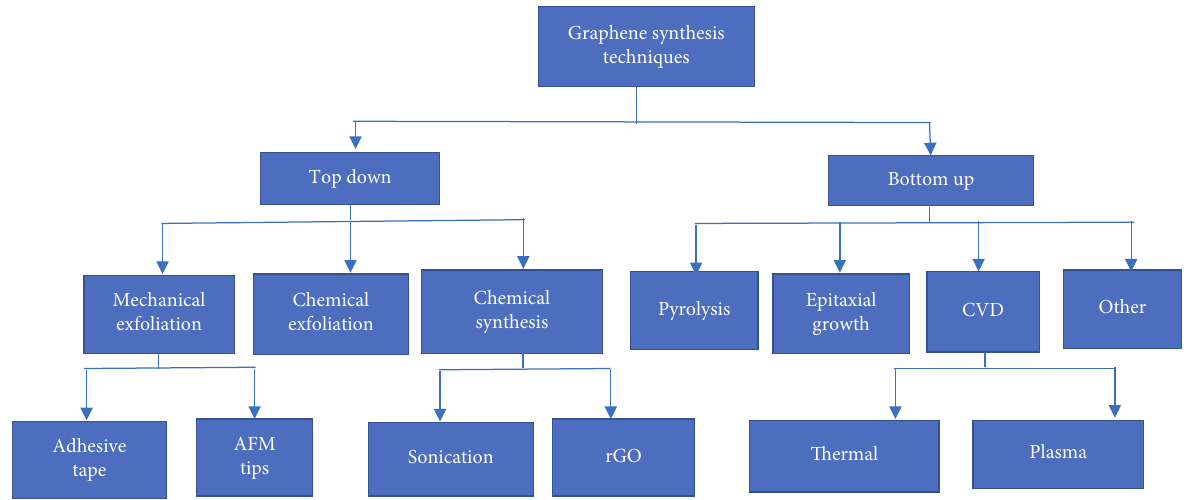
Figure 2: Flowchart of Hummer’s method [27].